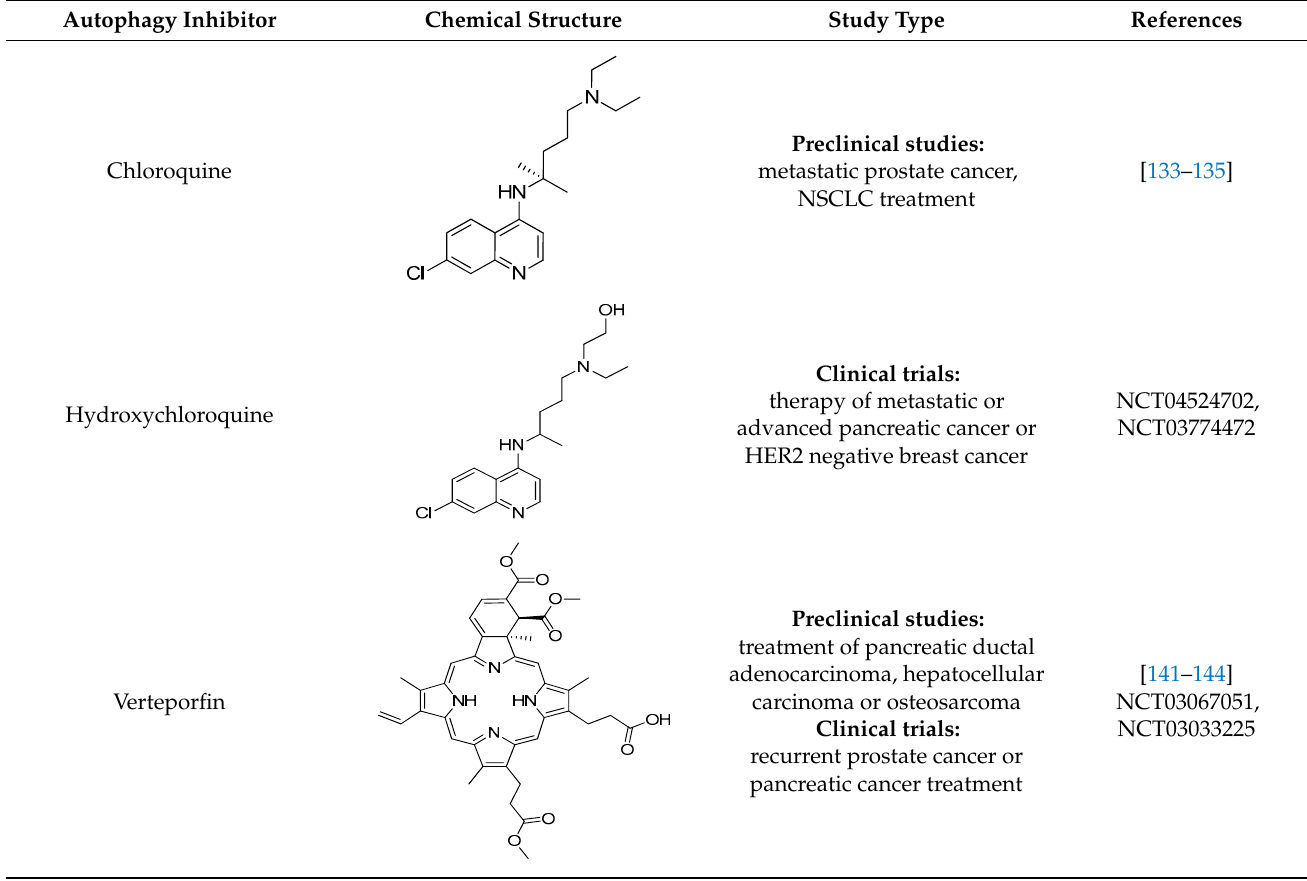
Table 1. Selected autophagy inhibitors under clinical investigation.